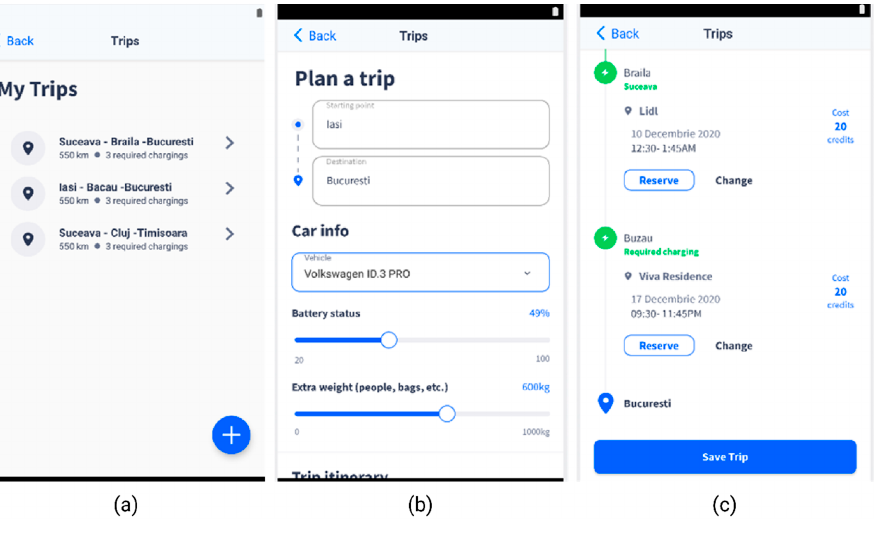
Figure 4. Smart EVC—Plan a trip section. ( a )—EV trips list; ( b )—Plan a trip feature, with details on the battery level and extra weight, based on which the necessary recharging operations are calcu- lated; ( c )—Proposed charging stations along the route, with reservation options.